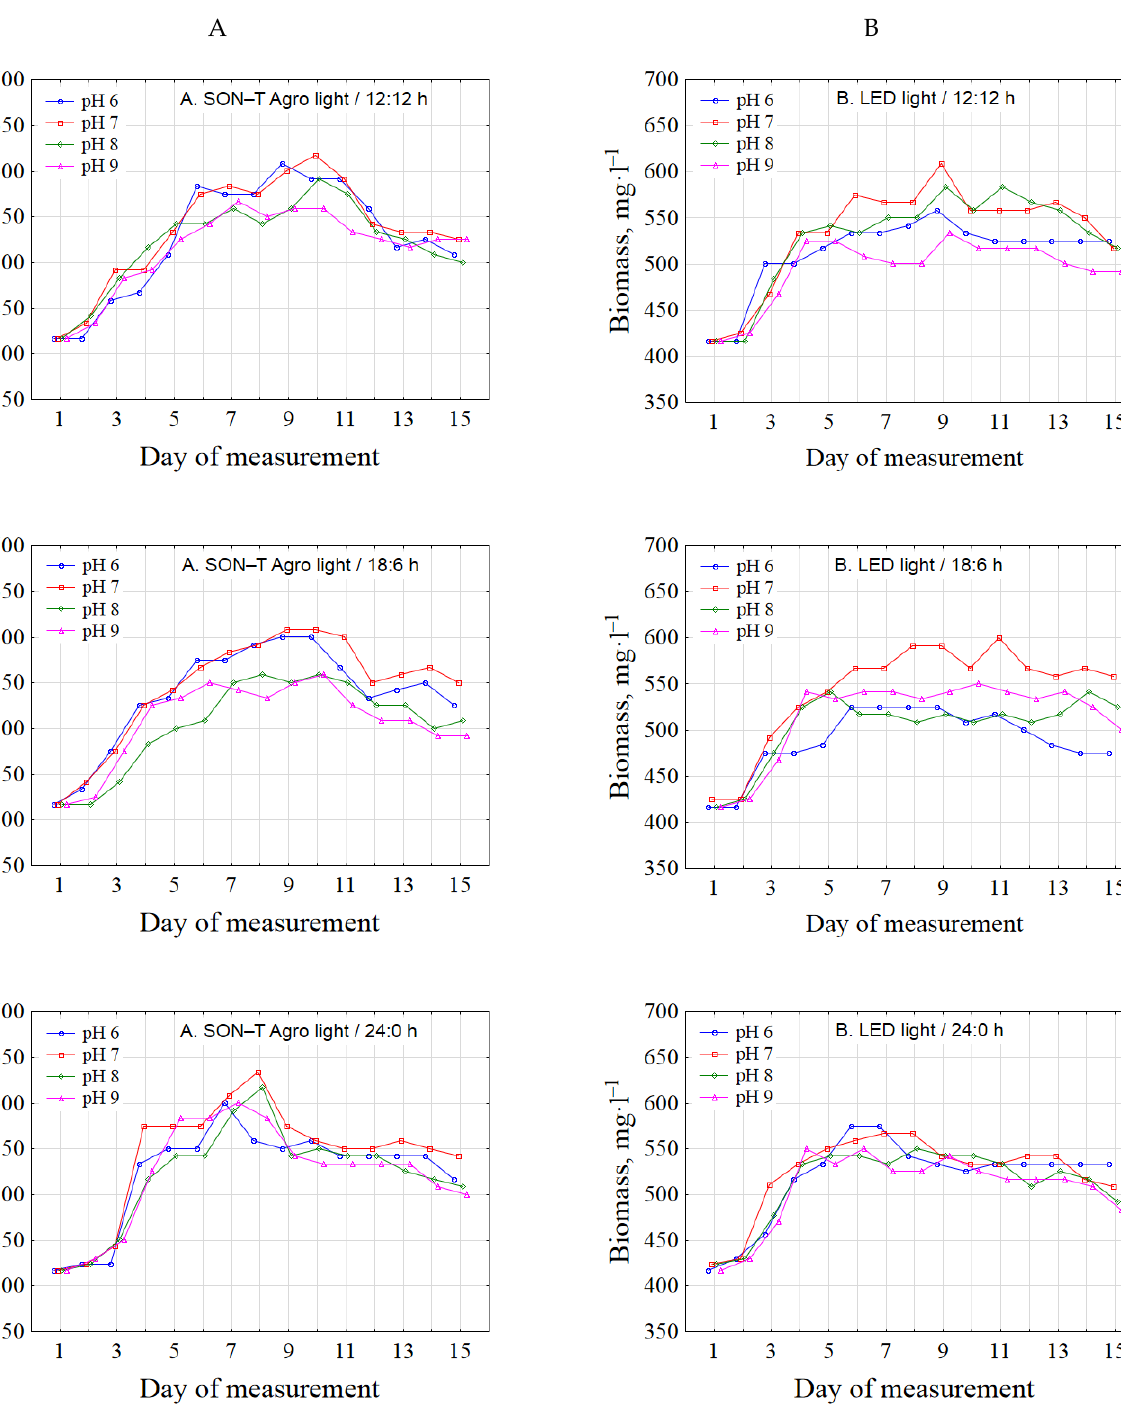
Figure 2. Dynamics of the growth of microalgae biomass in SON-T Agro light ( A ) and light-emitting diode (LED) light ( B ) during different light:dark